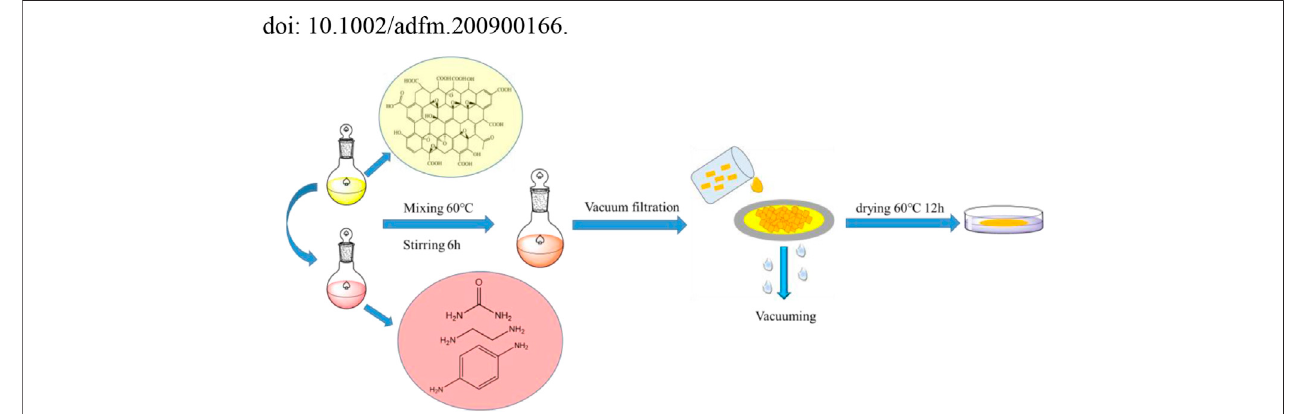
FIGURE 1 | GO composite membranes formation process.